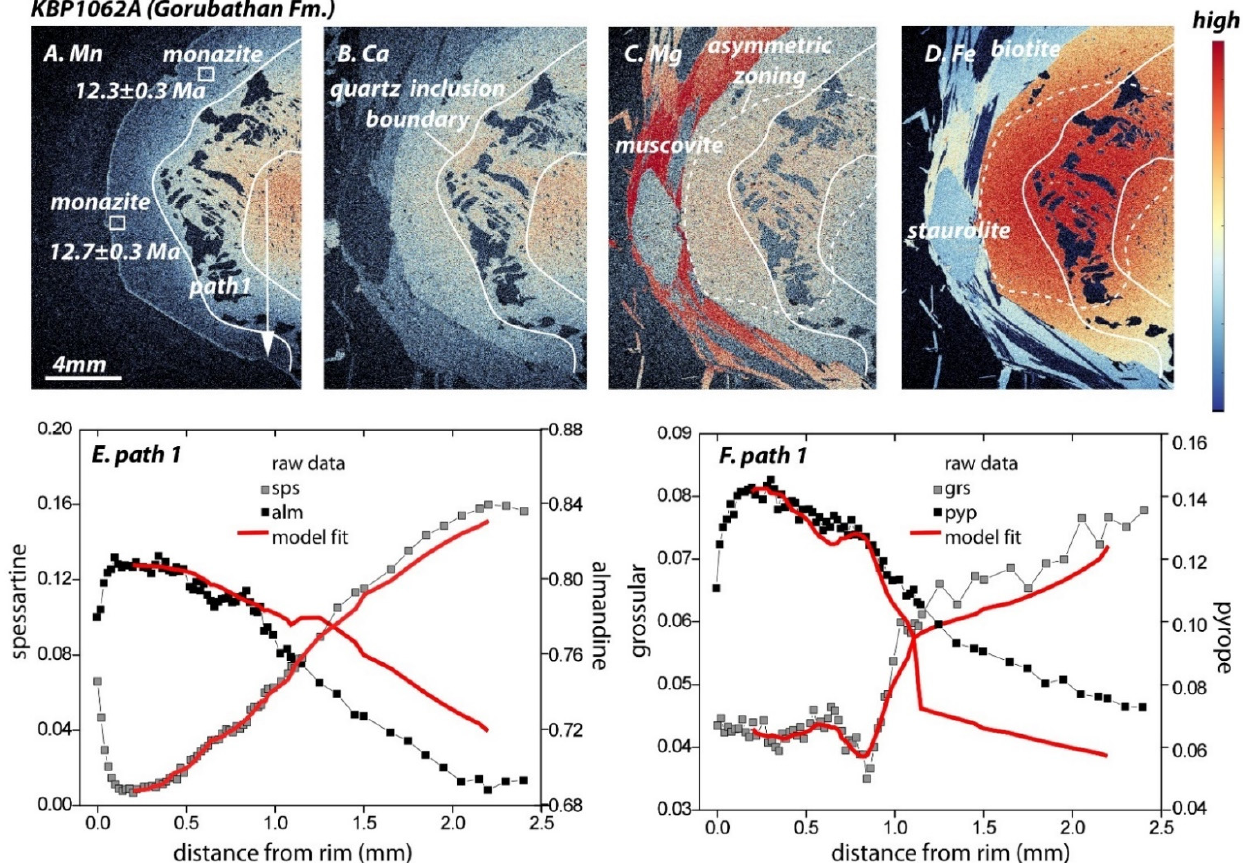
Figure 2. X-ray element maps of sample KBP1062A (Gorubathan Fm.) in ( A ) Mn, ( B ) Ca, ( C ) Mg, and ( D ) Fe. X-map tools were used to develop the maps in this and other figures [96]. Garnet compositions in spessartine (sps) and almandine (alm) (panel E ) and grossular (grs) and pyrope (pyp) (panel F ) were taken across the core to rim transect in panel ( A ). Monazite inclusions in garnet were dated in this sample by [5], who also reported the compositional data. The red lines in panels ( E ) and ( F ) show the prediction of the high-resolution P-T path generated for this garnet. The solid white line shows the boundary of the large quartz inclusions, whereas the dashed white line highlights the asymmetric zoning pattern in Mg and Fe.